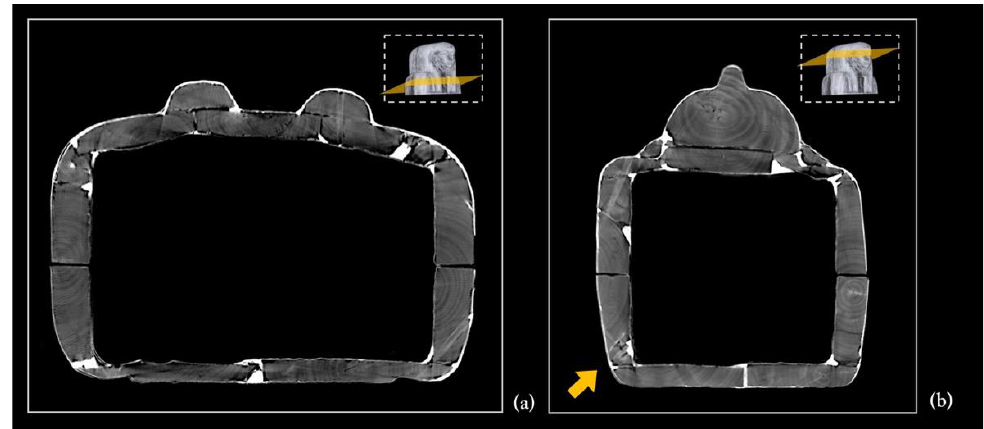
Figure 10. ( a ) Axial slice showing the matching growth rings of the side planks; ( b ) partial detachment of the growth rings, ring-shake (indicated by the orange arrow).